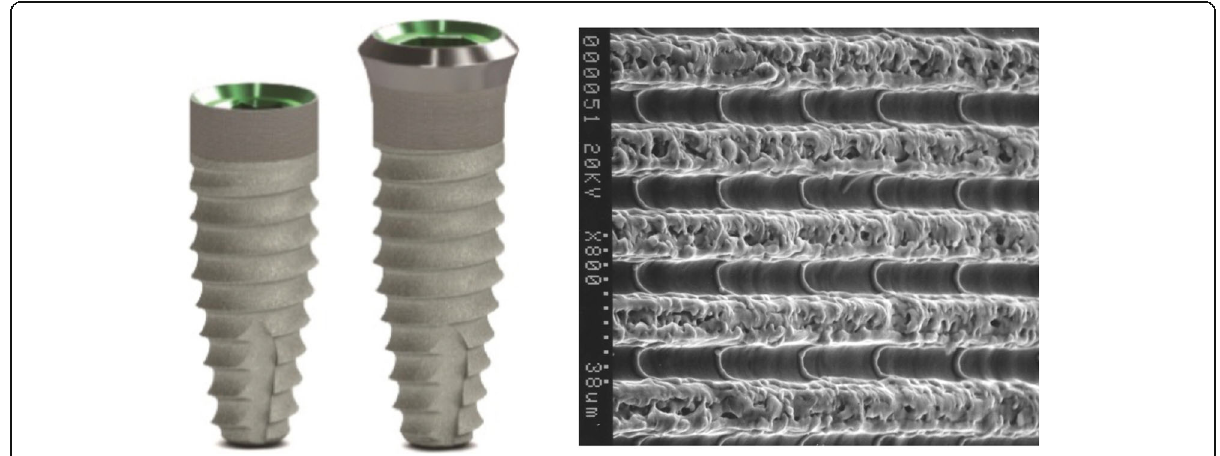
Fig. 3 Implants used in the present study and laser-microtextured intramucosal surface (original magnification ×